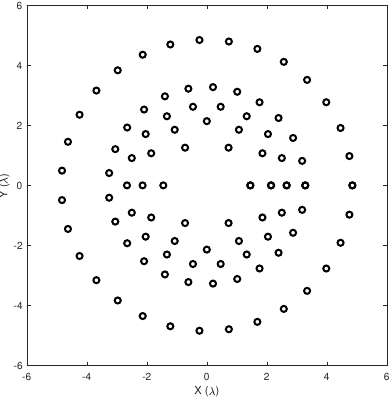
( b ) Beam number 1 is directed at 95 ◦ and beam number 2 at 145 ◦ .